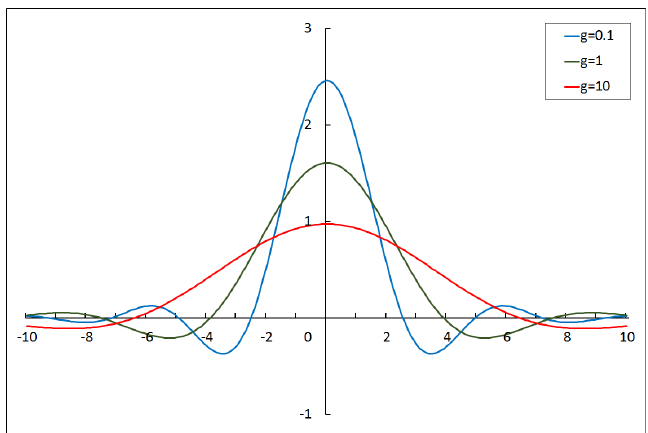
Figure 2. The 1-norm in the nonpolynomial sinh 4 ϕ theory plotted with respect to w for different values of the coupling constant g . The field scale ϕ 0 =